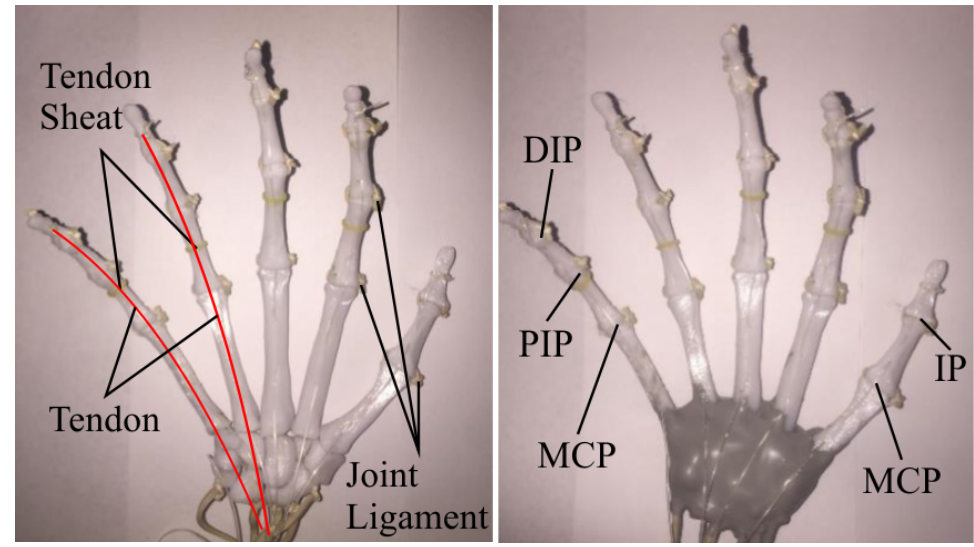
Figure 3. Musculoskeletal components and biomimetic structure of the soft robotic